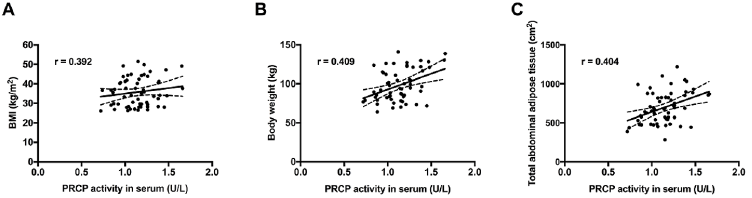
Fig 4. Correlations between serum PRCP activity and BMI, body weight and total abdominal adipose tissue. Correlation between serum PRCP activity and (A) BMI (p = 0.002), (B) body weight (p = 0.001) and (C) total abdominal adipose tissue (p = 0.001) in overweight/obese patients (n =